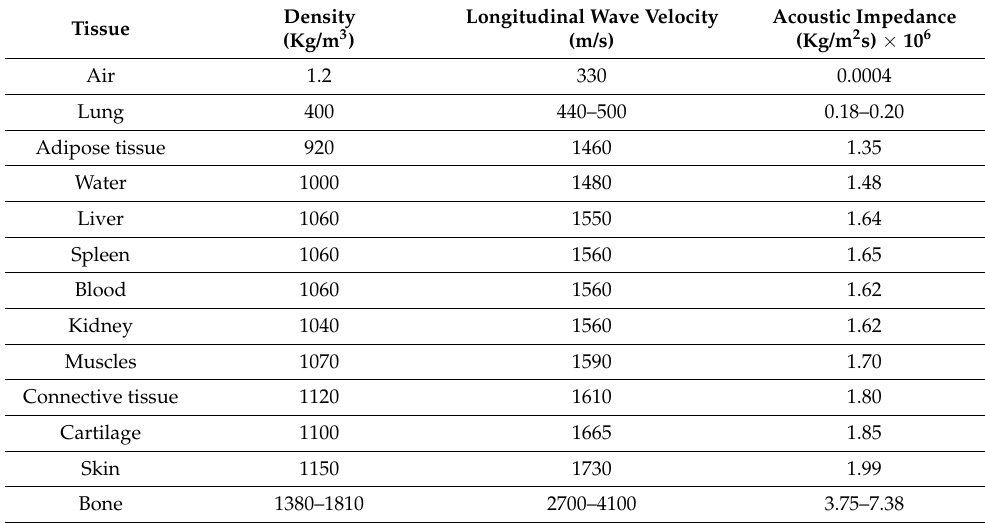
Table 3. Density, acoustic impedance, and longitudinal wave velocity of US in biological